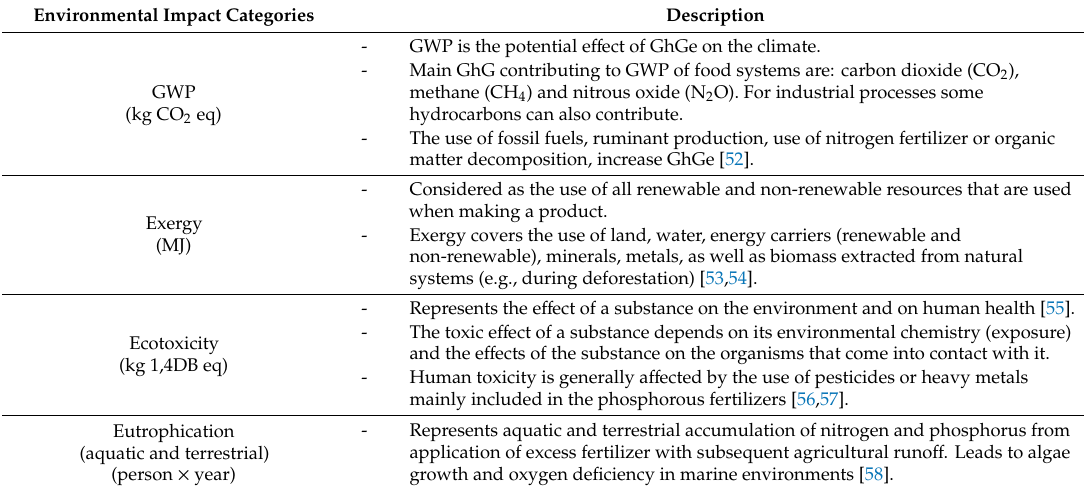
Figure 3. System boundaries of the Athlete’s Plate life cycle assessment used for the current study, ranging from production to consumer use. It includes all steps from agricultural production, processing, and packaging to transport, storage, and cooking. Table 1. Description of the environmental impact categories.